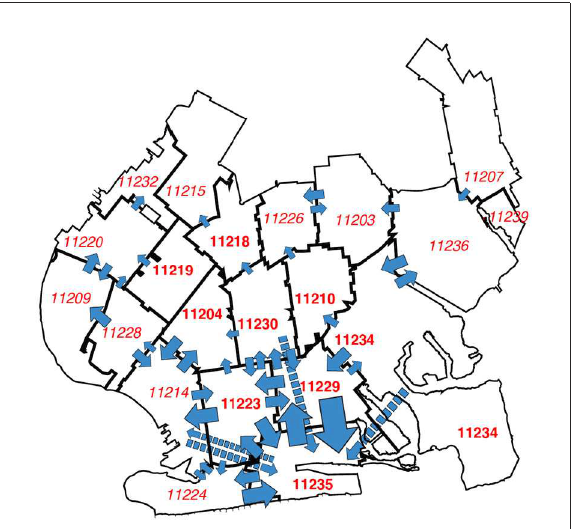
FIGURE8 Most frequent transits between ZCTAs during 10/25 through 11/28/2020. The width of each blue arrow is proportional to the number of device movements in the Safegraph cohort. The longer arrows with dashed lines represent transits between non-contiguous ZCTAs. The number of device movements ranged from 21139 (corresponding to the transit 11229 → 11235) to 5002 (corresponding to 11214 → 11224). Transits between ZCTAs with fewer than 5,000 movements are not shown. The transits captured by the arrows comprised 44.5% of all device movements between ZCTAs. For base map of New York City ZCTAs, see ref.